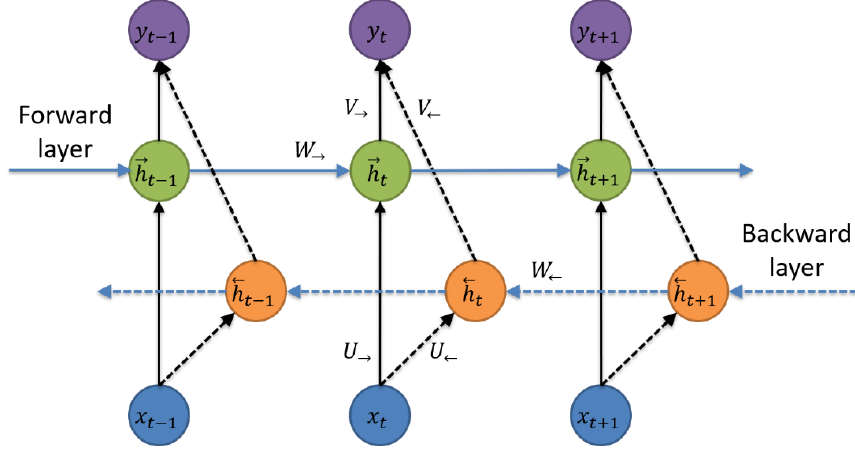
Figure 4. Bi-RNN model.